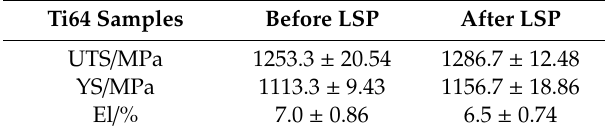
Figure 8. Engineering stress–strain curves of SLM-fabricated Ti64 samples before and after LSP; error bars represent one standard deviation. Table 2. Tensile properties of SLM-fabricated Ti64 samples before and after